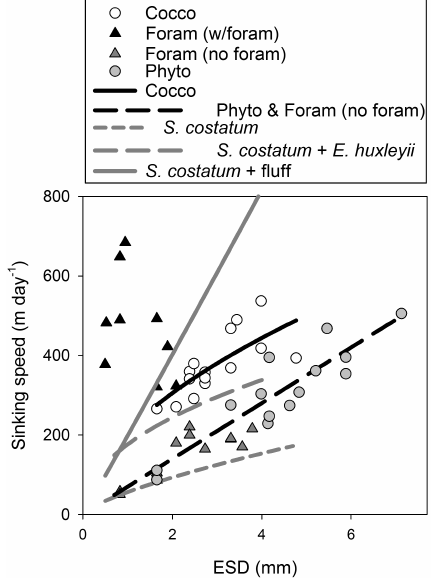
Fig. 8. Sinking speeds versus size (equivalent spherical diameter) of the different types of aggregates formed in this experiment. The solid curves shown for the aggregates from this experiment are y = 21(ESD) 0 . 54 for the Cocco aggregates ( r 2 = 0.55), and y = 70(ESD) 1 . 00 for the Phyto and the Foram (no foram) aggregates taken together ( r 2 = 0.82). The dotted and the dashed lines show for comparison the relationships reported for Skeletonema costatum aggregates and aggregates of a mixture of S. costatum and Emilia- nia huxleyi by Iversen and Ploug (2010) and for aggregates of S. costatum mixed with resuspended fluff from the seafloor (Ziervogel and Forster,